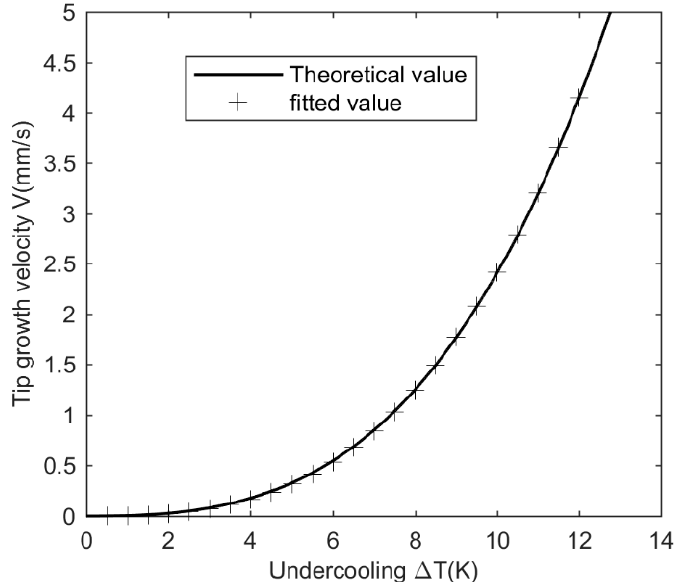
Figure 8. Dendrite tip growth velocity as a function of the undercooling.